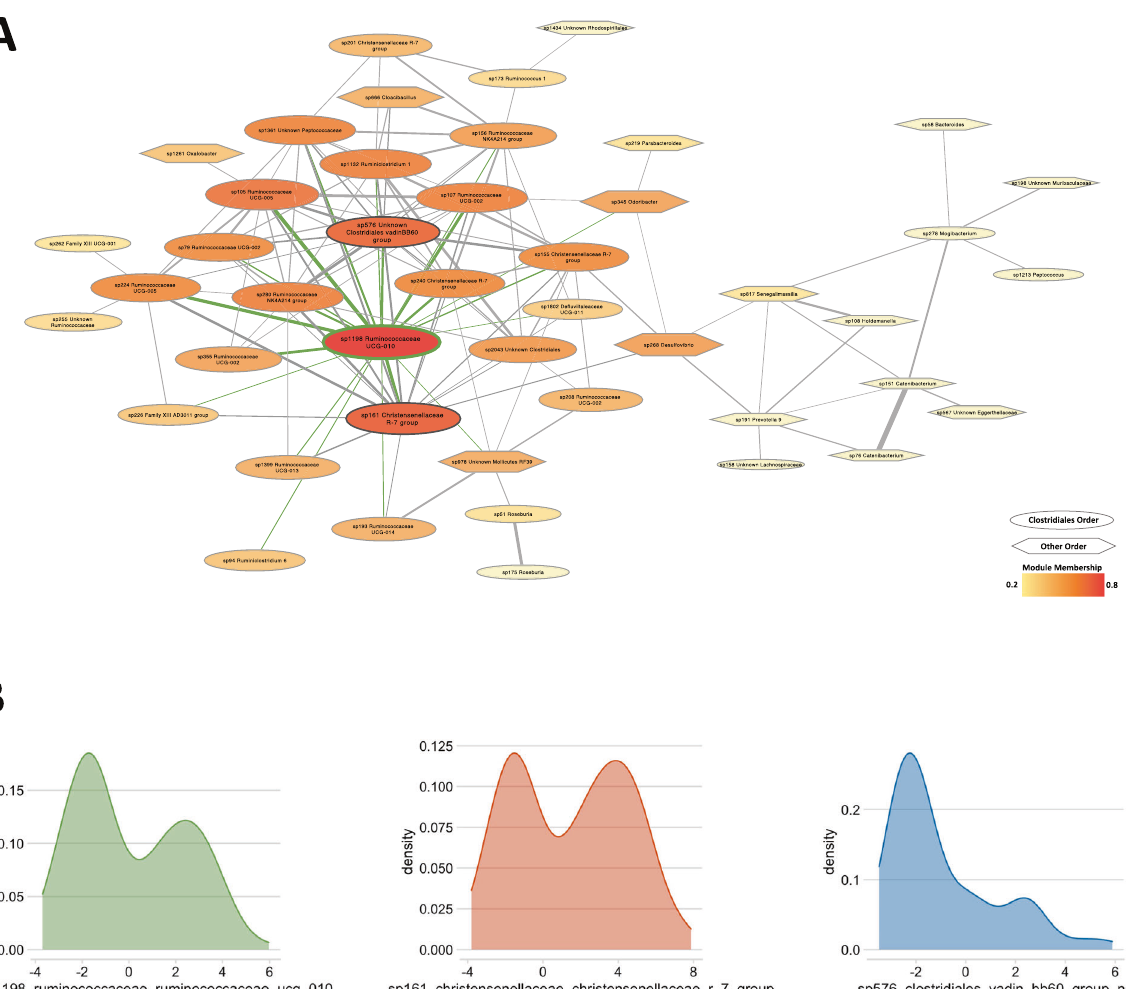
Fig. 3 The brown human gut microbial network – which is positively associated with clinical scores of anxiety, depression, and anhedonia – is enriched and regulated by butyrate-producing human gut microbes. A Visualization of the brown gut microbial network as a hard-thresholded correlation network. Network connections were determined using Pearson correlation. Connections were pruned to taxa correlations where R > 0.35. Edges correspond to correlation strength, with the thinnest correlations corresponding to r = 0.35. Nodes are sized and colored by Brown module membership, and shapes are coded by taxonomic order. B Probability density function plots for hub taxa of the brown network. Hub taxa represent probable network low predictive accuracy on validation datasets (Supplementary Fig. S7). There was no predictive utility of microbial taxa for anhedonia clinical scores in our study (Supplementary Fig. S8). To identify taxa of interest for potential biomarkers of depression, anxiety, or anhedonia we examined the consensus of all three analytical methods — WCNA, ALDEx2 and random forest. The taxa that met the criteria for signi fi cance in WCNA and either ALDEx2 or random forest methods are listed in consensus tables (Tables 2, 3). Brown module hub taxa sp1198 Ruminococ- caceae UCG-010 met all criteria for GAD-7 consensus taxa. Further, its association with GAD7 score remained signi fi cant after BH correction (Supplemental Table 2). Several additional taxa outside the brown module were also identi fi ed by meeting ALDEx2 and being sp28 Lachnospiraceae_NA ( β GAD7 = 0.28). Although these individual taxa did not survive multiple correction in our analyses, this list represents potential taxa that may be considered as potential microbiota biomarkers for anxiety symptoms. PHQ-9 did not have any brown module hub taxa that achieved consensus criteria. However, GAD7 and PHQ-9 shared several positively